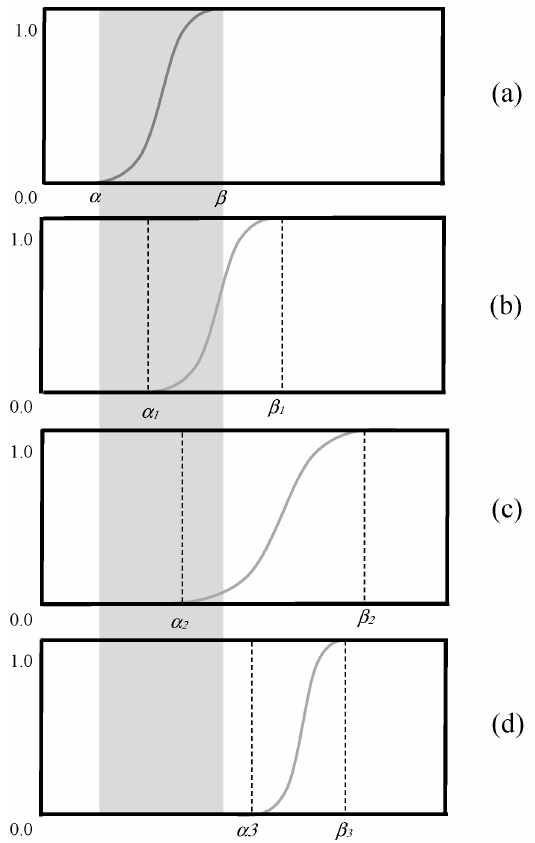
Figure 3. Possible changes of membership function during adaptation. ( a ) initial fuzzy function; ( b ) adapted: upper and lower border shifted but range fixed; ( c ) adapted: upper and lower border shifted and range stretched; ( d ) upper and lower border shifted and the range reduced.